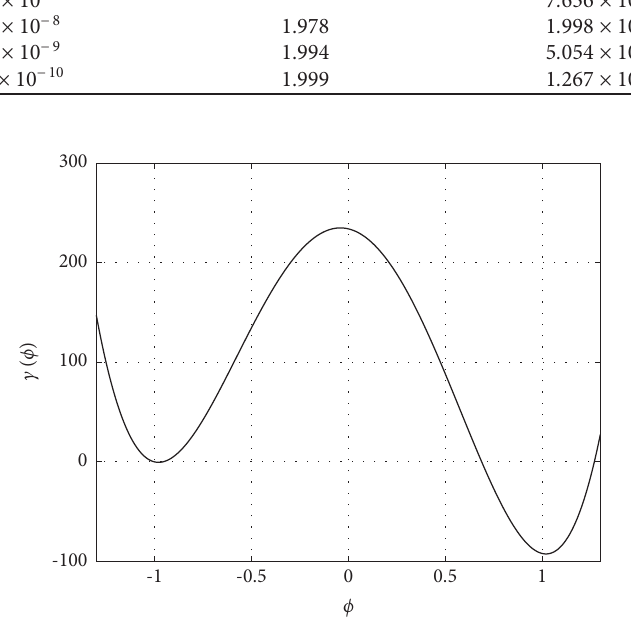
Figure 1: Plot of c ( ϕ ) � 280 ( 1 + ϕ ) 2 ( 1 − ϕ ) 2 − 46 ( 1 + ϕ ) .